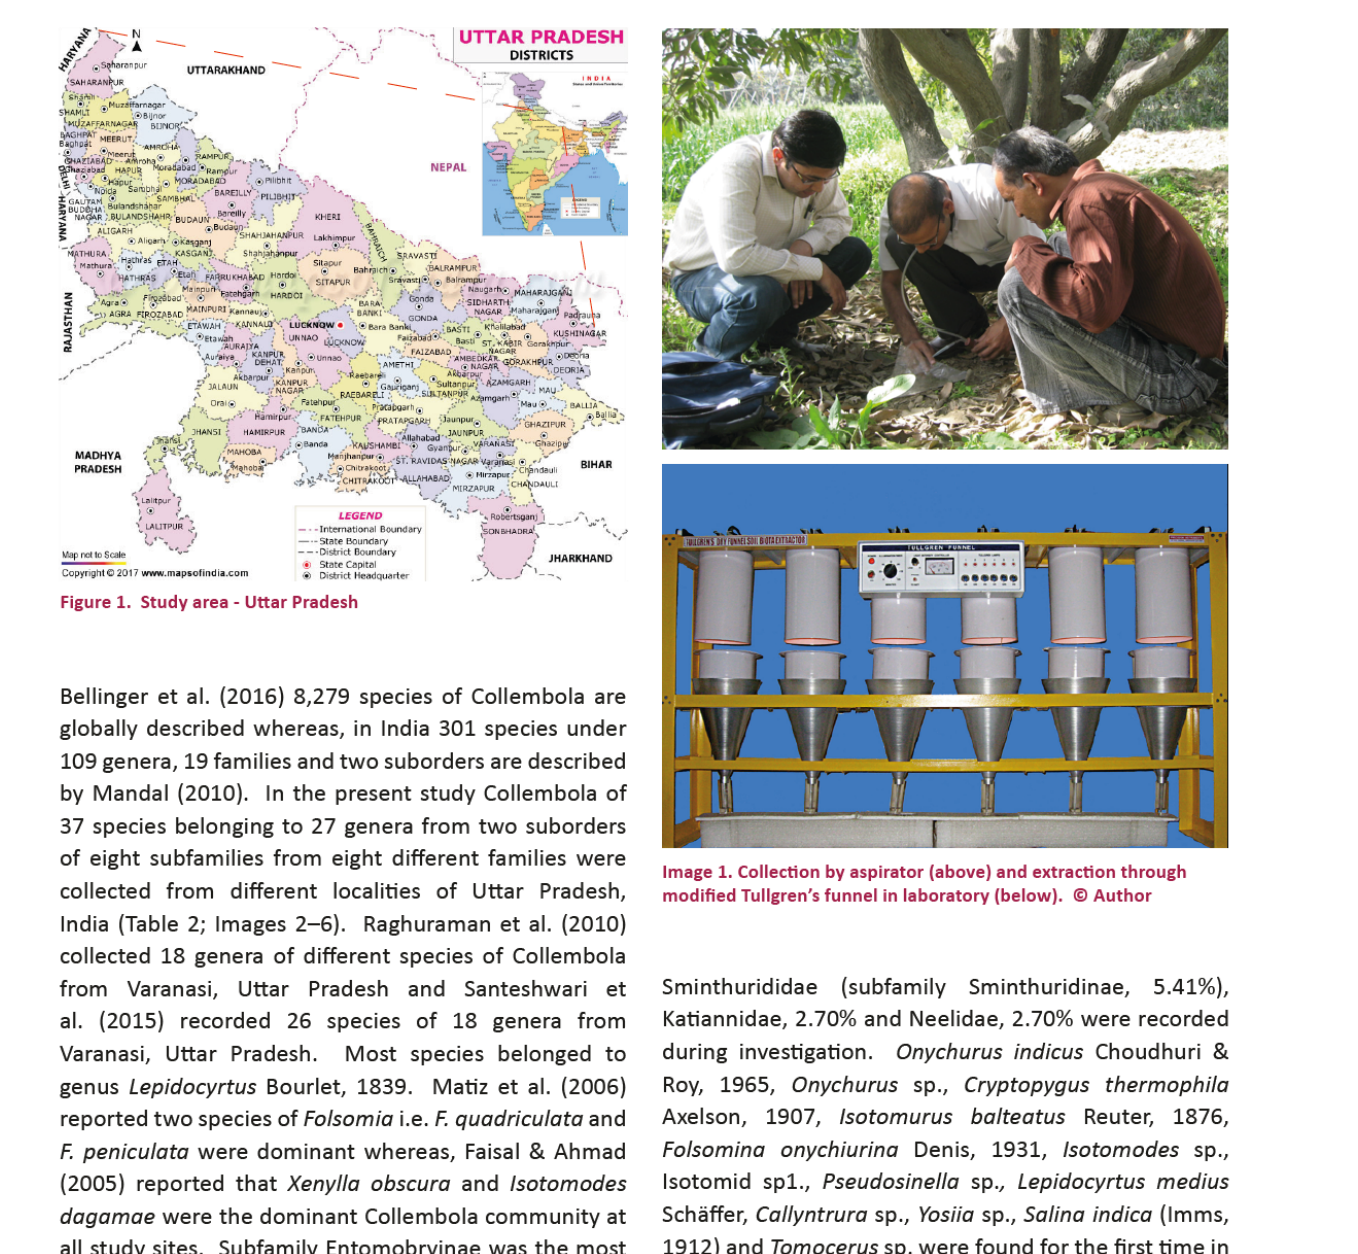
Image 1. Collecfion by aspfirattor (above) and exttracfion tthrough modfified Tullgren’s ffunnel fin laborattory (below). ©